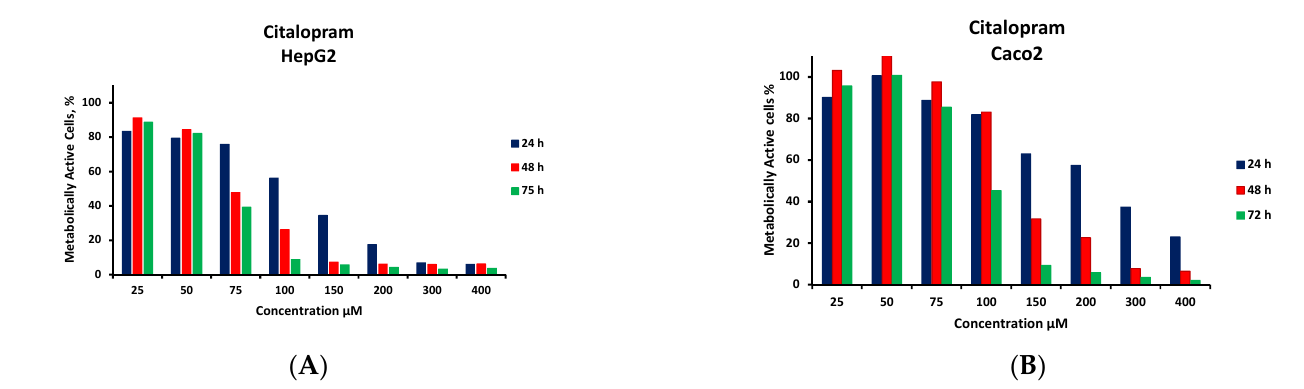
Figure 8. Cytotoxicity monitoring ( A ) citalopram against HepG2 ( B ) citalopram towards Caco2.